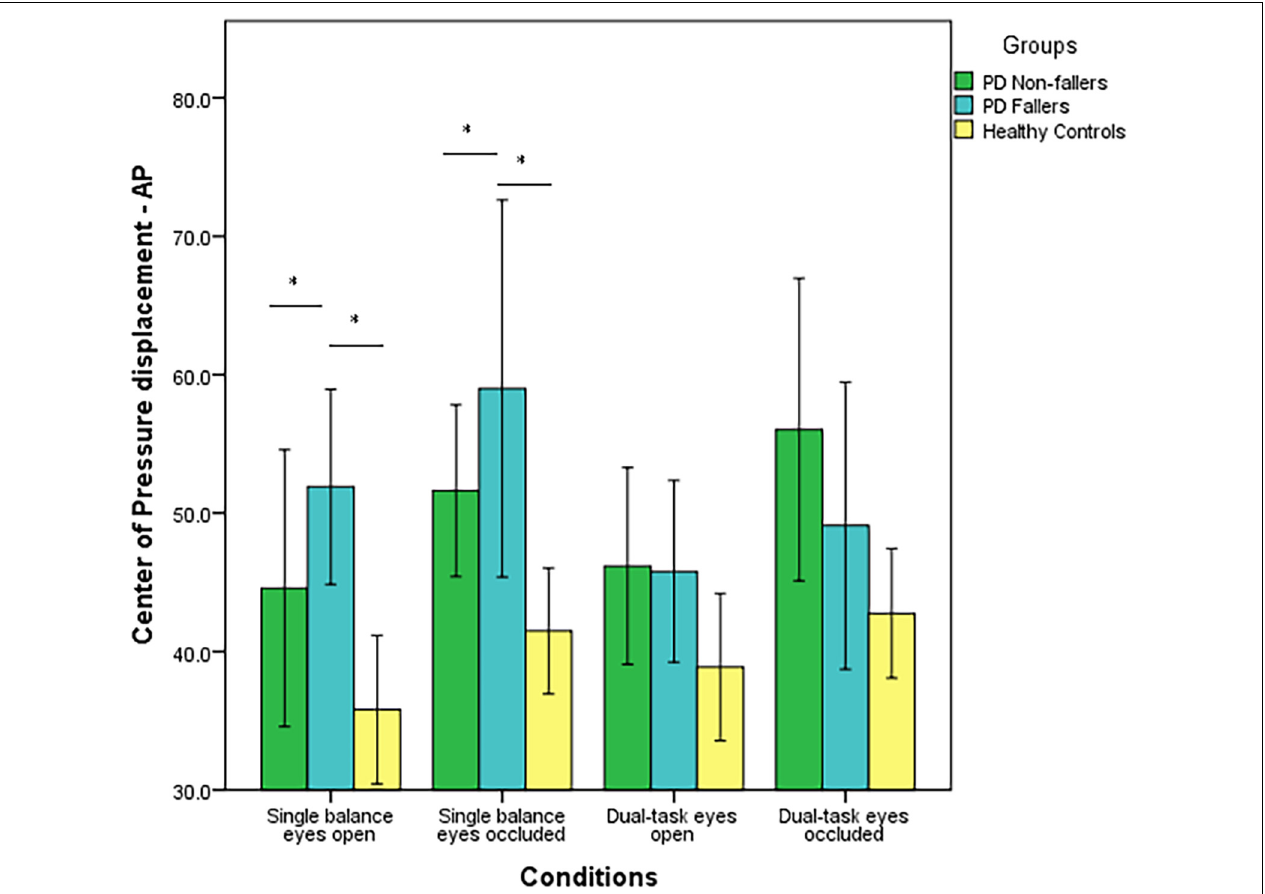
FIGURE 2 | Mean values (in mm 2 /s) and standard error of the mean (SEM) of Center of Pressure (CoP) displacement in the Anterior-Posterior (AP) direction of PD fallers, PD non-fallers, and healthy controls across the conditions. * p < 0.01.